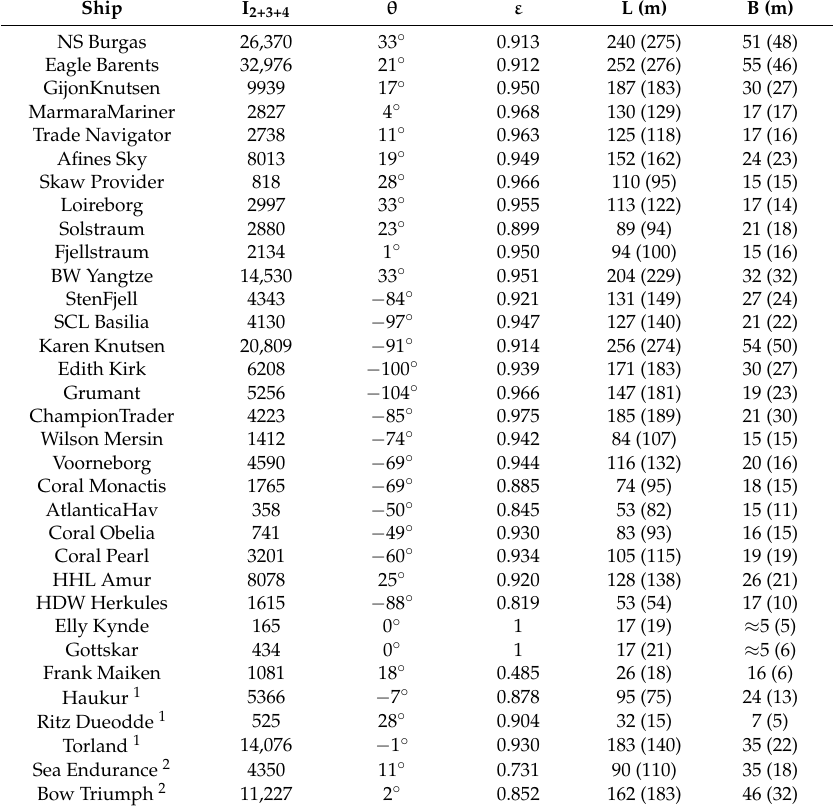
Table 1. Ship parameters for the ships in S2 Figure 1: reflectance (I), heading angle ( θ ), ellipticity ( ε ), length (L) and breadth (B), see Appendix A. Numbers in parentheses are lengths and breadths found from reported values in the AIS ship